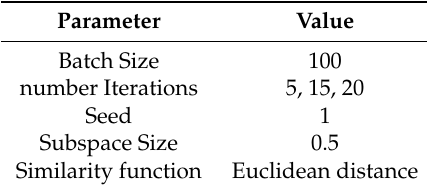
Table 2. Parameters Settings of RSL